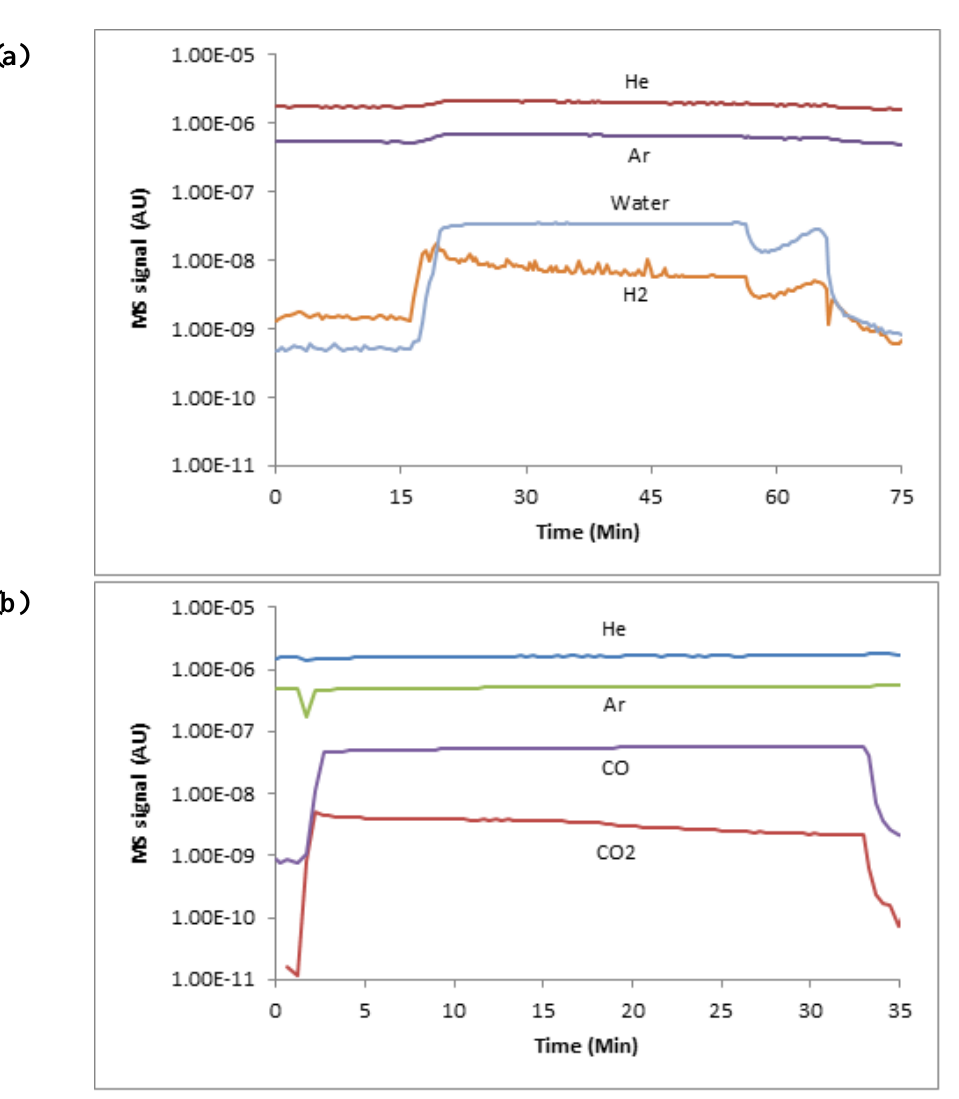
Figure 2. MS traces of initial oxidation cycle data for a reactor temperature of 873 K ( a ), and of initial reduction cycle data for a reactor temperature of 873 K ( b